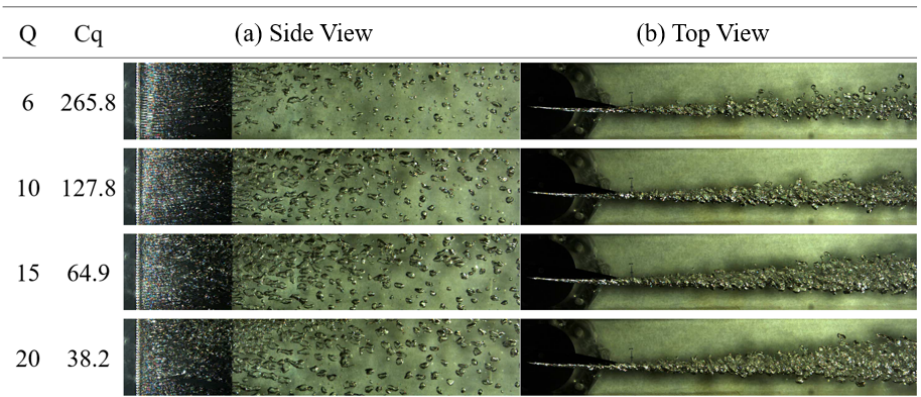
Figure 2. The instantaneous images showing the bubbles at Fn = 30.3 for Q = 6 to 20 SLPM . ( a ) Side view at Q = 10 SLPM . ( b ) Top view at Q = 10 SLPM . (Multimedia view.)